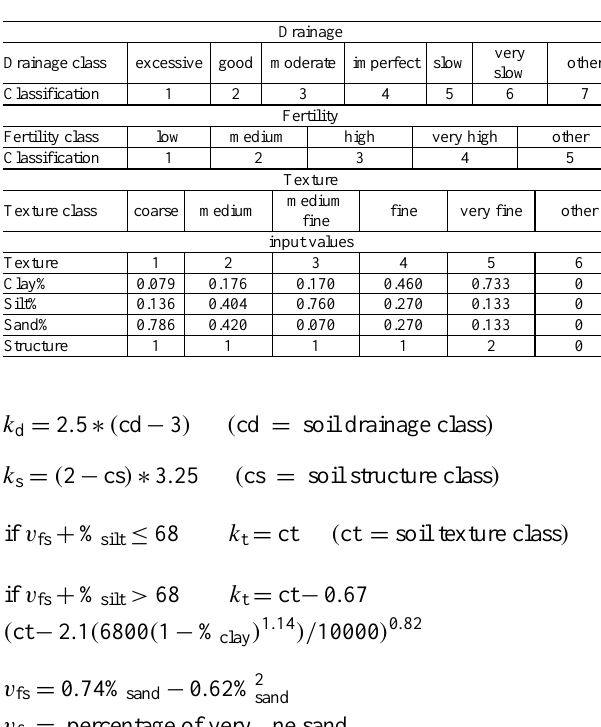
Table 2. Drainage class, fertility class, texture class classification based on a pedological map of Sardinia.